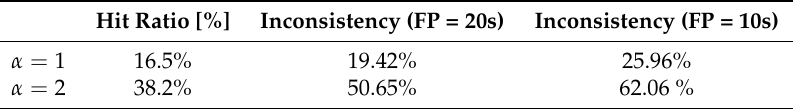
Table 1. Cache hit ratio and inconsistency metrics in presence of CEE+LRU policy, when varying the Zipf skewness α and the FP